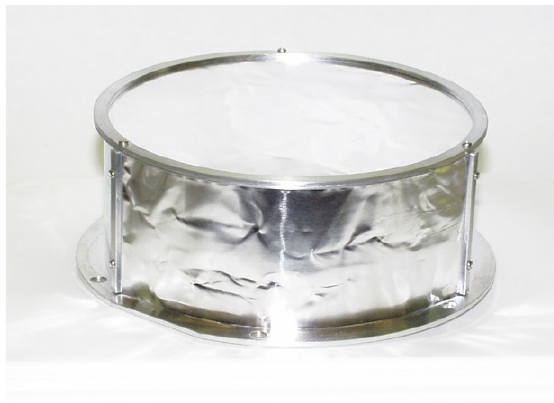
Fig. 2. Stencil placed on top of foil inside of weighing paper.